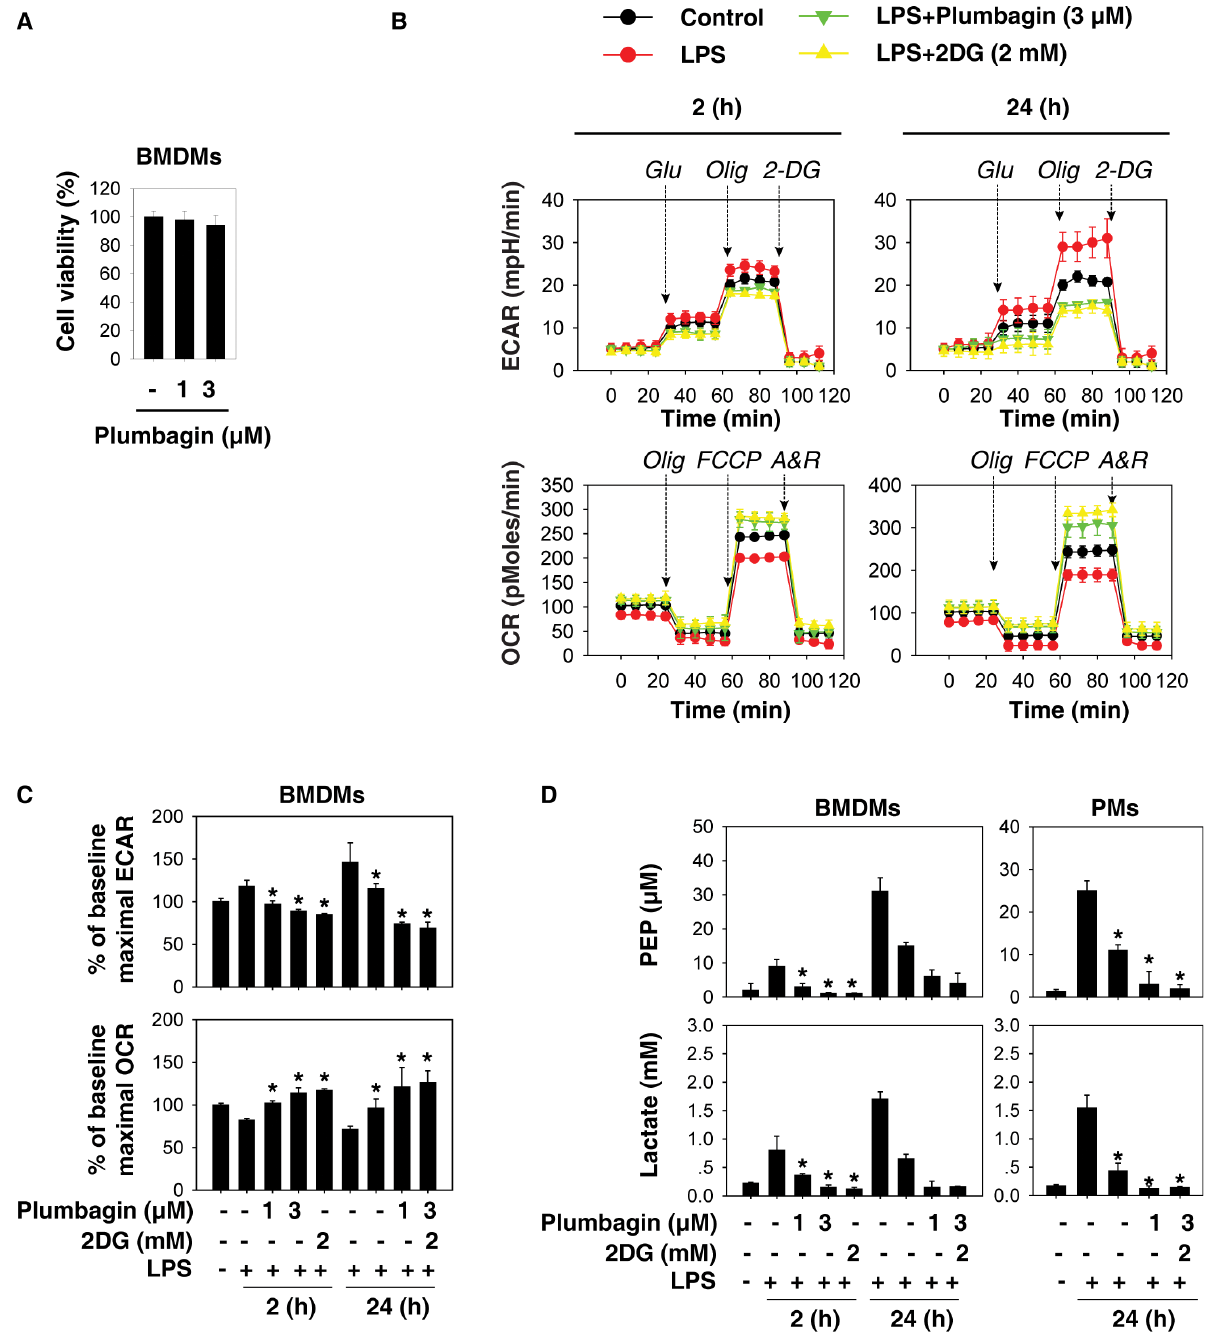
Figure 1. Plumbagin inhibits aerobic glycolysis in activated macrophages. (A) Bone marrow-derived macrophages (BMDMs) were treated with plumbagin (1 and 3 μ mol/L) for 24 h, and cell viability was analyzed. (B–C) BMDMs and peritoneal macrophages (PMs) were pretreated with plumbagin and 2DG for 1 h and then stimulated with lipopolysaccharide (LPS) (100 ng/mL) for 2 or 24 h. After the drug treatment ended, the cells were changed to fresh culture medium and then the oxygen consumption rates (OCR, indicative of oxidative phosphorylation) and extracellular acidification rates (ECAR, indicative of glycolysis) were monitored using the Mito Stress Test Kit (Oligomycin “Olg,” 100 μ mol/L; FCCP, 100 μ mol/L; Rotenone/antimycin A “A/R,” 50 μ mol/L) and Glycolysis Stress Test Kit (Glucose “Glu,” 10 mM; Oligomycin “Olg,” 1 μ mol/L; 2-DG, 50 μ mol/L) by Seahorse Bioscience Extracellular Flux Analyzer. (D) In parallel, phosphoe- nolpyruvate (PEP) and lactate levels were assayed using commercial kits (n = 3, *, p < 0.05 versus LPS